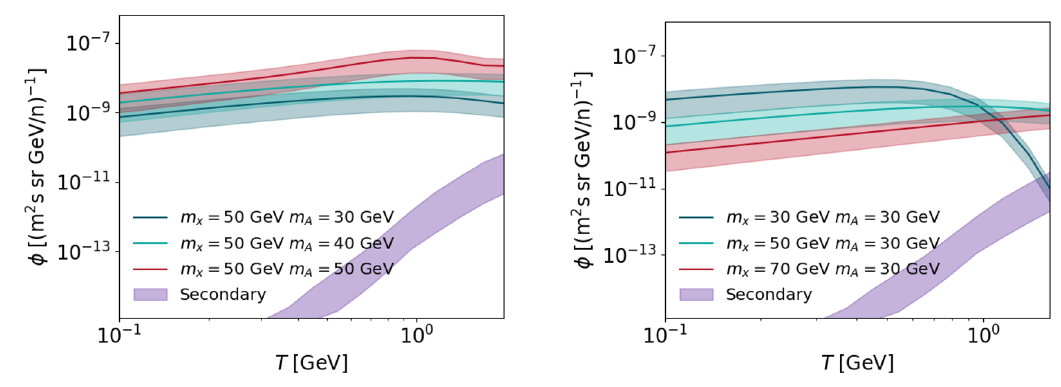
Figure 12. Predicted antihelium (cid:13)ux spectra of DPDM for various choices of m A 0 (left) and m (cid:31) (right). The antihelium secondary is taken from [41], where the shaded region represents a range of coalescence momenta and the MED propagation parameters have been assumed.